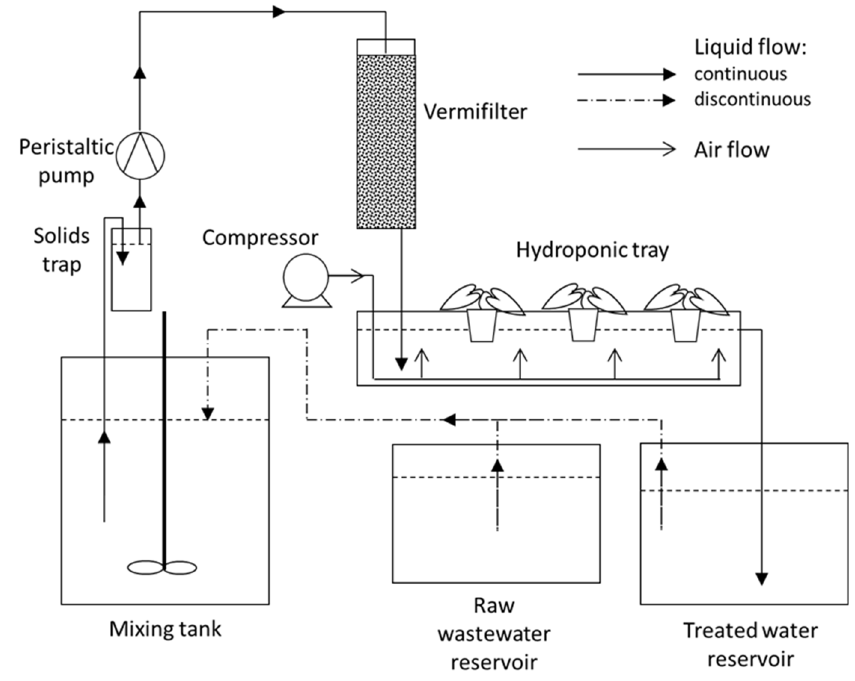
Figure 1. Schematic representation of the built vermifiltration-hydroponic system. Arrows indicate the liquid and air flow directions.